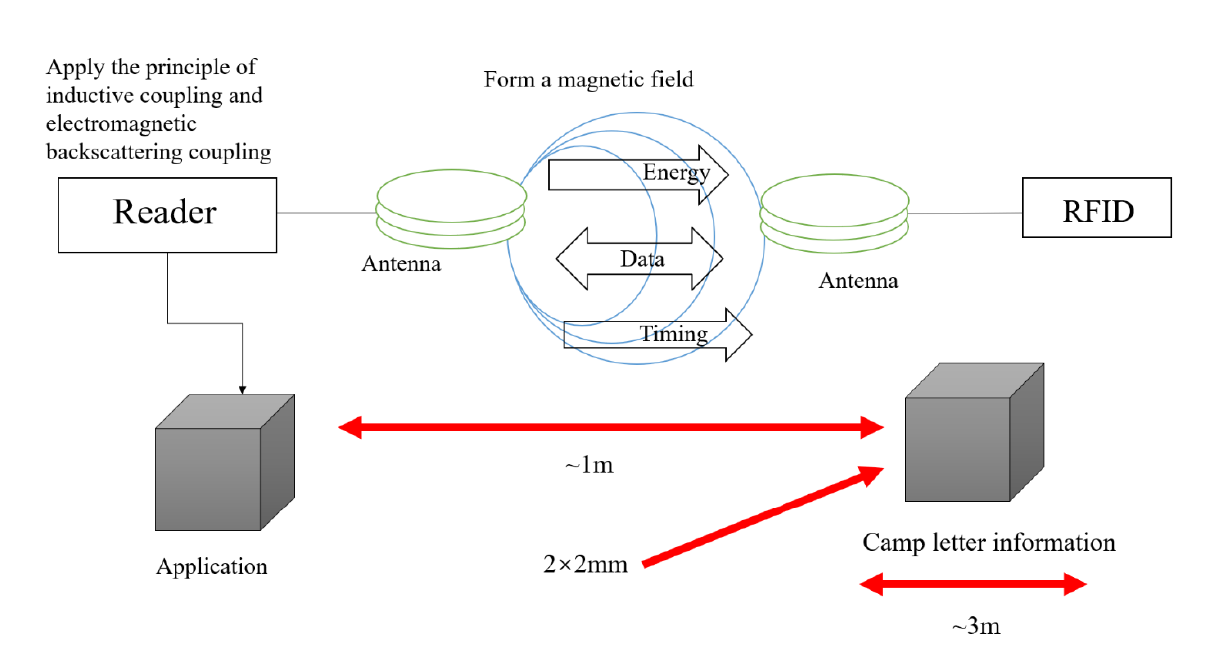
Figure 3. How RFID